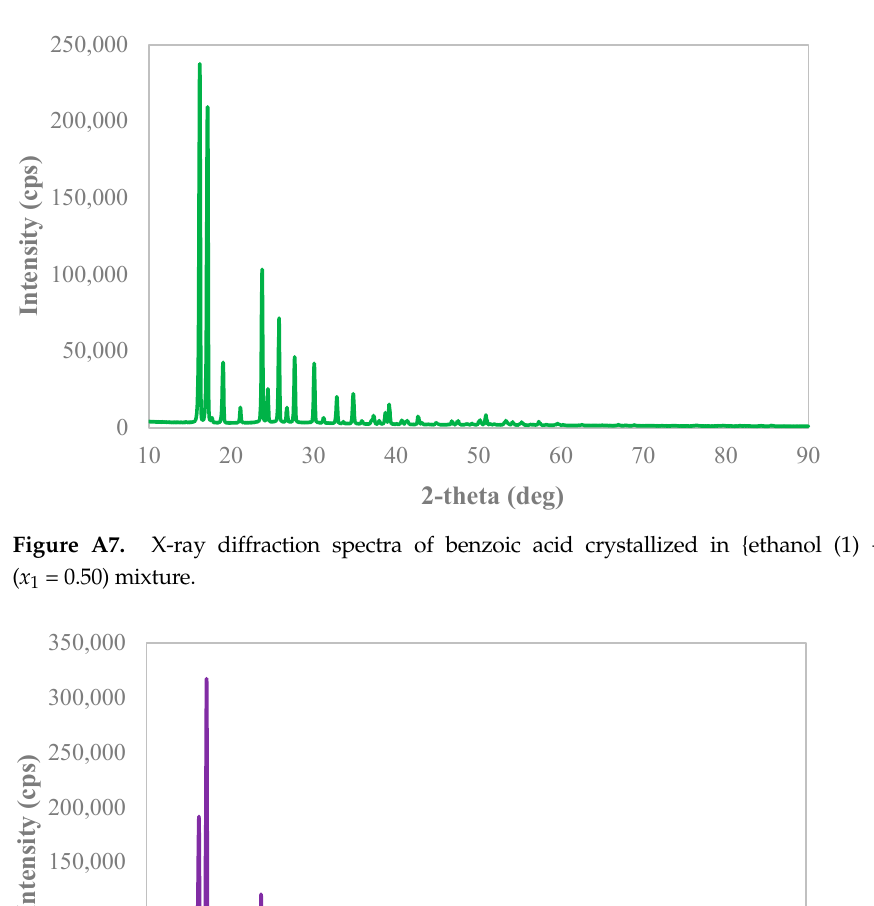
Figure A8. X-ray diffraction spectra of benzoic acid crystallized in neat ethanol.